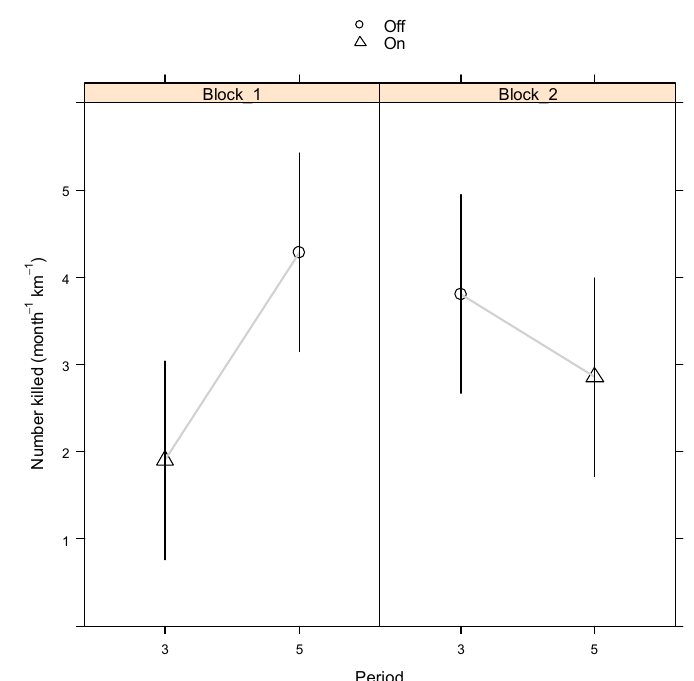
Figure 1. Standardised roadkill (month − 1 km − 1 ) for Bennett’s wallaby for Periods 3 and 5 for Crossover means by Block. Single Standard Error (SE) bars are shown.